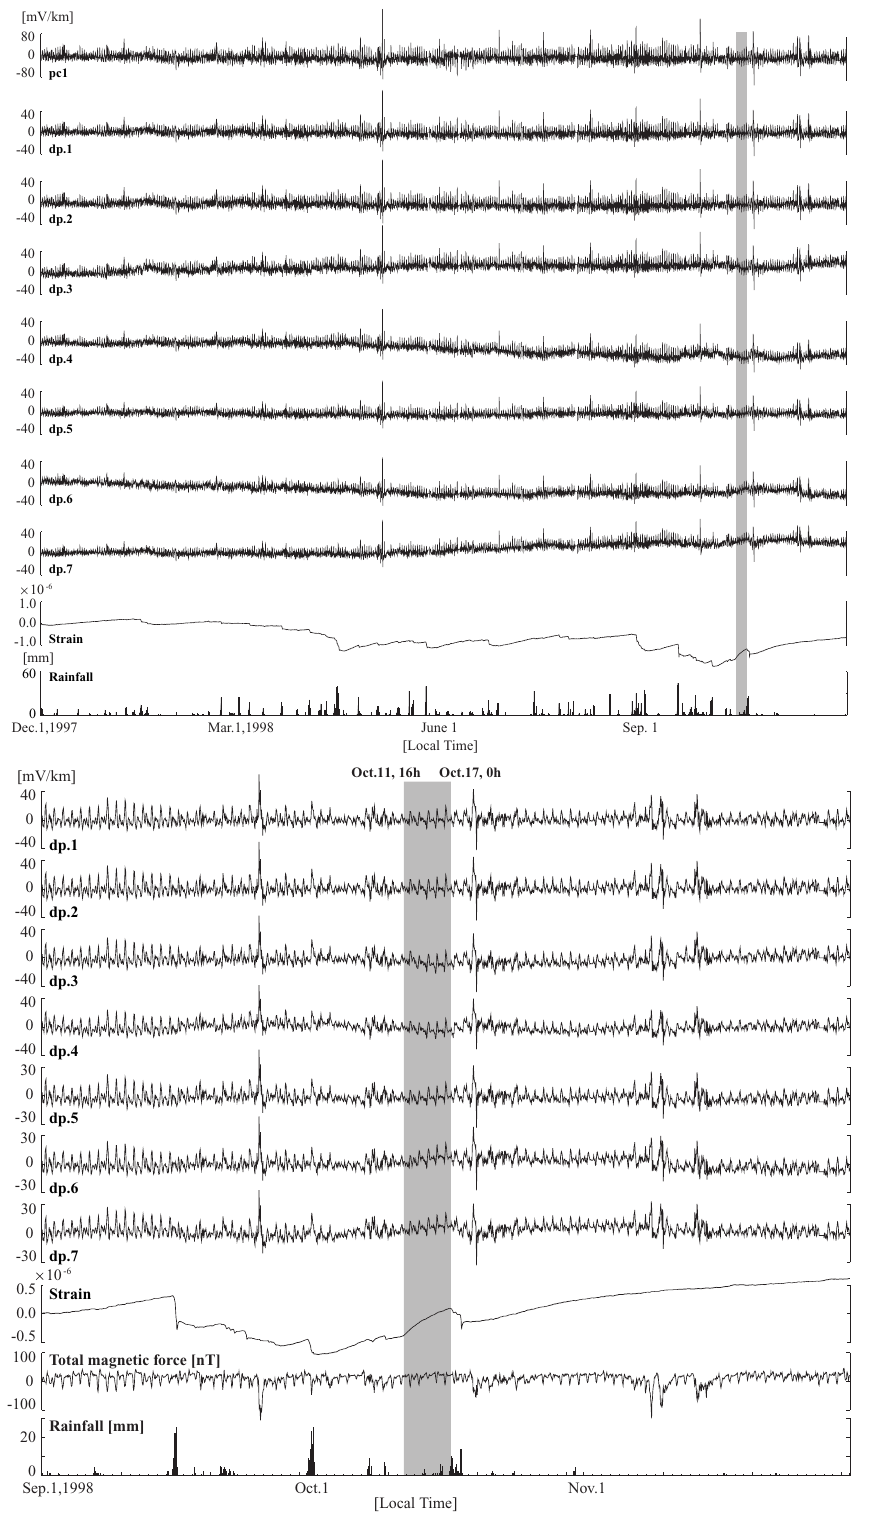
Fig. 3. (a) One-year records and (b) three-month records of the geoelectric field, volumetric strain and rainfall at Shimizu. The shaded rectangle indicates the period of the volumetric strain anomaly in question. The panel second from the bottom in (a) shows the total magnetic force at